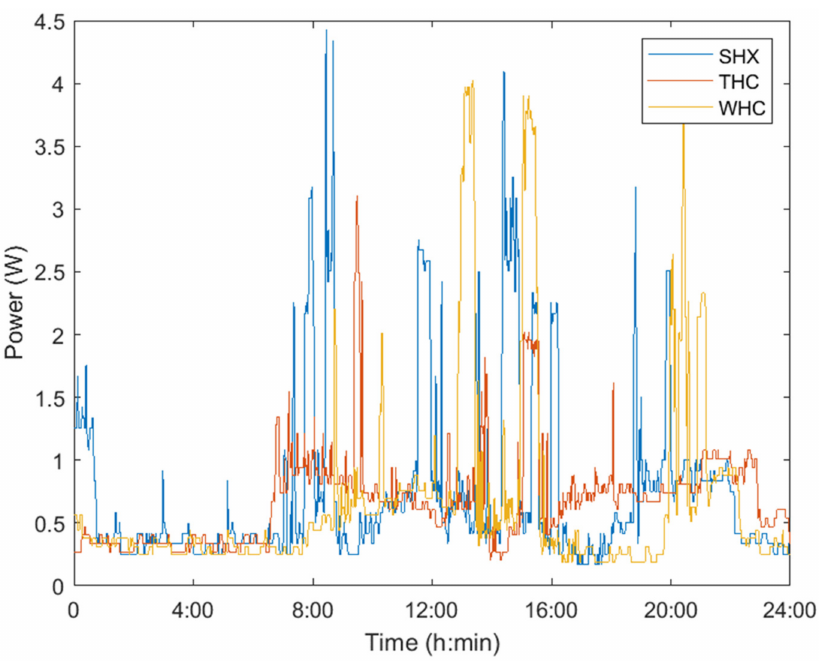
Figure 1. Daily electrical scaled load profile for the single-family house in Jordan during day types SHX, THC and WHC, scaled according to VDI-4655 guidelines.